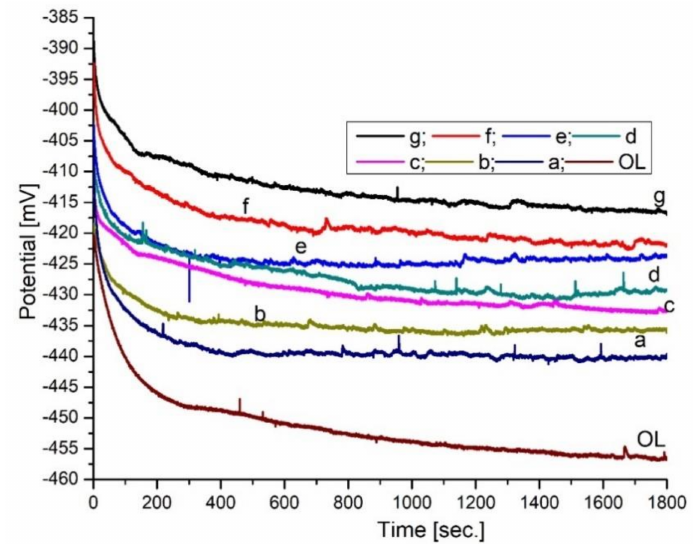
Figure 4. The OCP of the covered electrodes after 30 min immersion in 0.1 M HCl as it fol- lows: OL (bare electrode); ( a ) MnTa 2 O 6 ; ( b ) 5,10-(4-carboxy-phenyl)-15,20-(4-phenoxy-phenyl)- porphyrin; ( c ) 5,15-(4-carboxy-phenyl)-10,20-bis-phenylporphyrin; ( d ) MnTa 2 O 6 /5,10-(4-carboxy- phenyl)-15,20-(4-phenoxy-phenyl)-porphyrin; ( e ) 5,10-(4-carboxy-phenyl)-15,20-(4-phenoxy-phenyl)- porphyrin/MnTa 2 O 6 ; ( f ) MnTa 2 O 6/ 5,15-(4-carboxy-phenyl)-10,20-bis-phenylporphyrin; ( g ) 5,15-(4- carboxy-phenyl)-10,20-bis-phenylporphyrin/MnTa 2 O 6 .